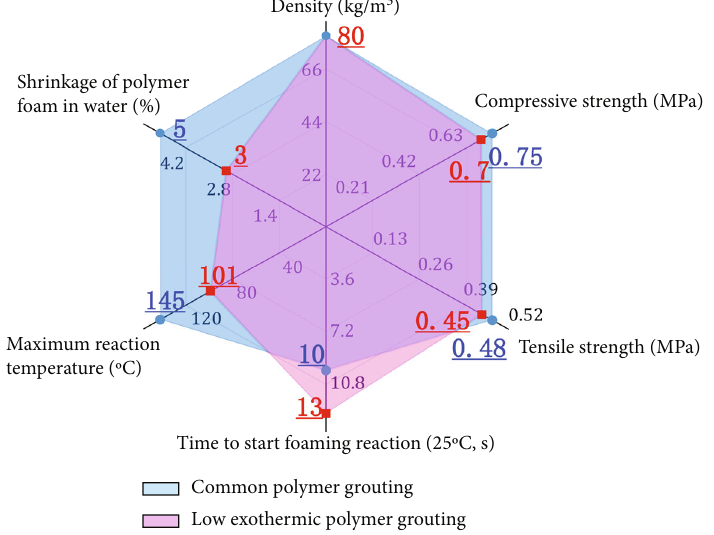
Figure 12: Comparison of physical and mechanical